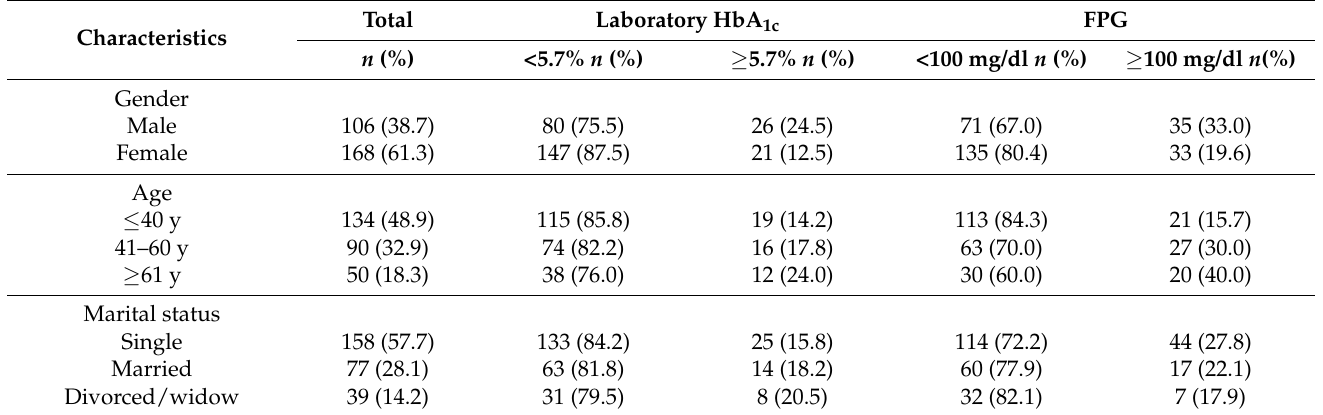
Table 1. Subjects’ characteristics distributed according to laboratory